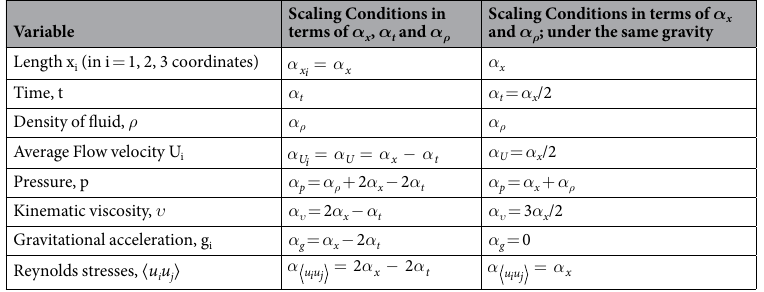
Table 1. The scaling exponents obtained by the one-parameter Lie group of point scaling transformations for the variables of the 3D Reynolds Averaged Navier-Stokes